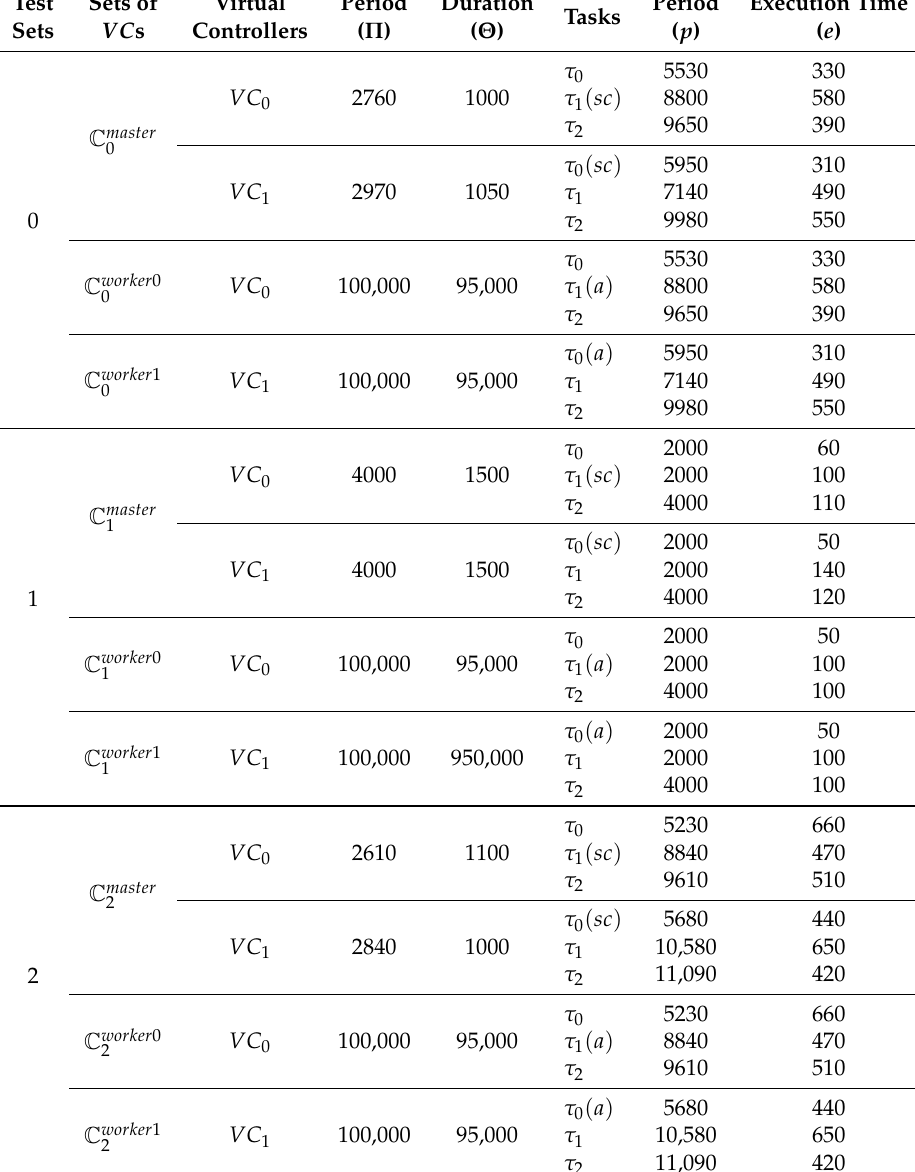
Table 1. Test sets (time unit: µ s).